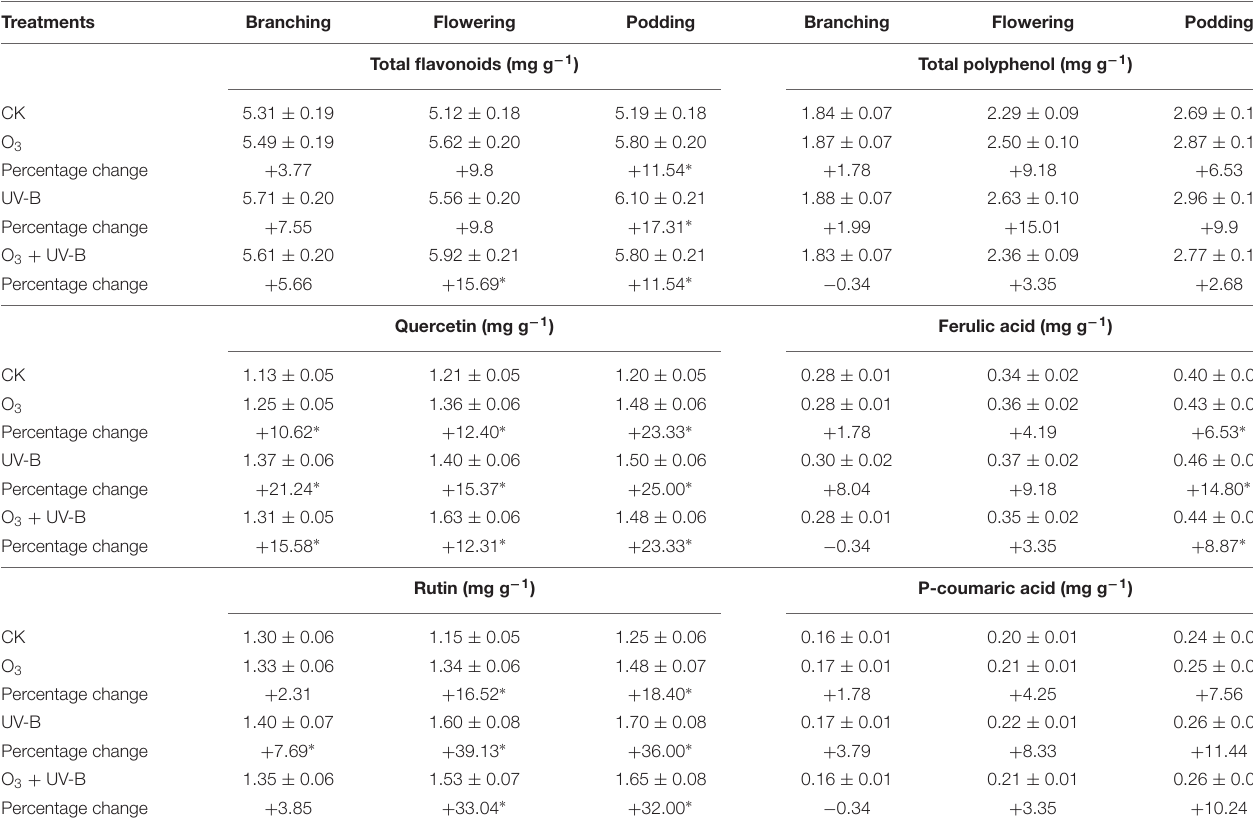
TABLE 1 | Differences in secondary metabolisms of soybean roots in response to control treatment (CK), elevated O 3 treatment (O 3 ), enhanced UV-B treatment (UV-B) and O 3 + UV-B treatment (O 3 + UV-B) at stages of branching, flowering, and podding (mean ± SD, n = 3). Treatments Branching Flowering Podding Branching Flowering